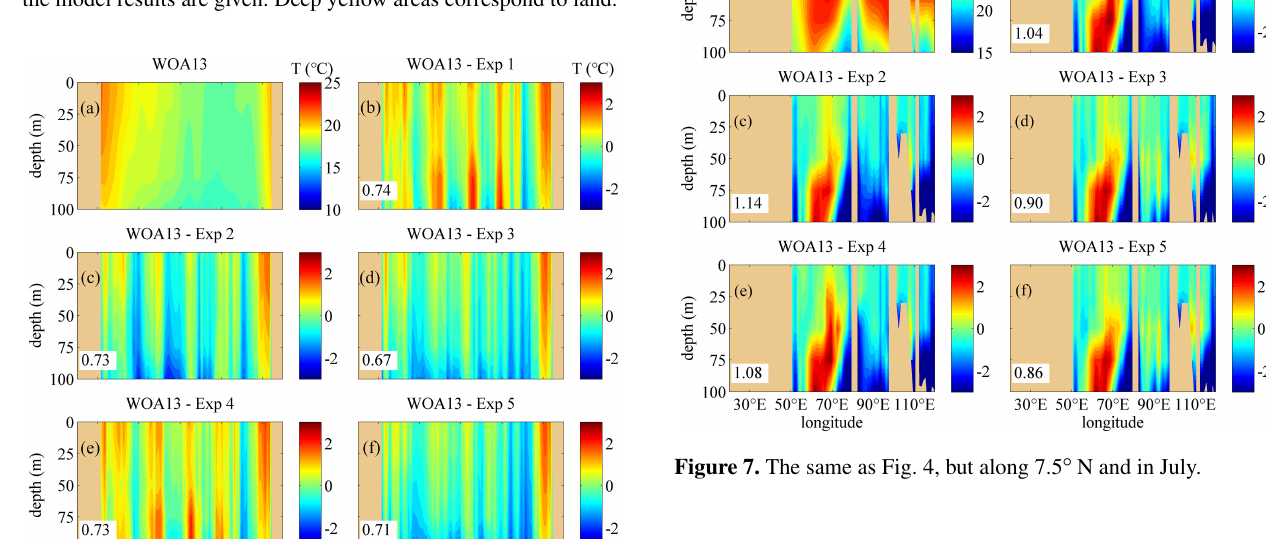
Figure 4. The vertical temperature profiles along 30.5 ◦ S in Jan- uary. (a) The temperature structure from the monthly WOA13 data (units: degrees). (b–f) The difference of the temperature calculated by subtracting the monthly mean results simulated in Exp 1–Exp 5 from the monthly WOA13 data, respectively. The RMSE of the tem- perature in the upper 100m regions between the WOA13 data and the model results are given. Deep yellow areas correspond to land.